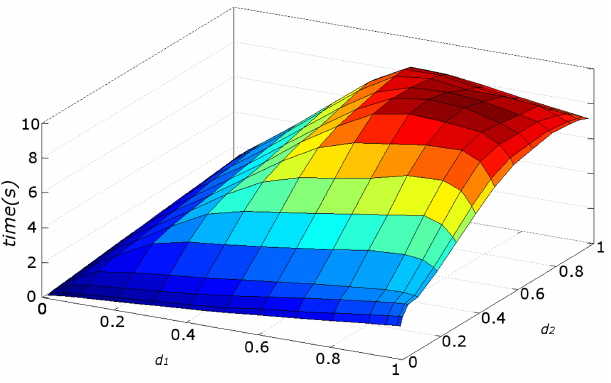
Fig. 3. Execution times of iSM, with different levels of den-